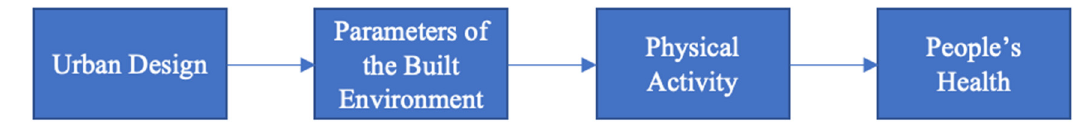
Figure 1. The causal chain from urban design to health.